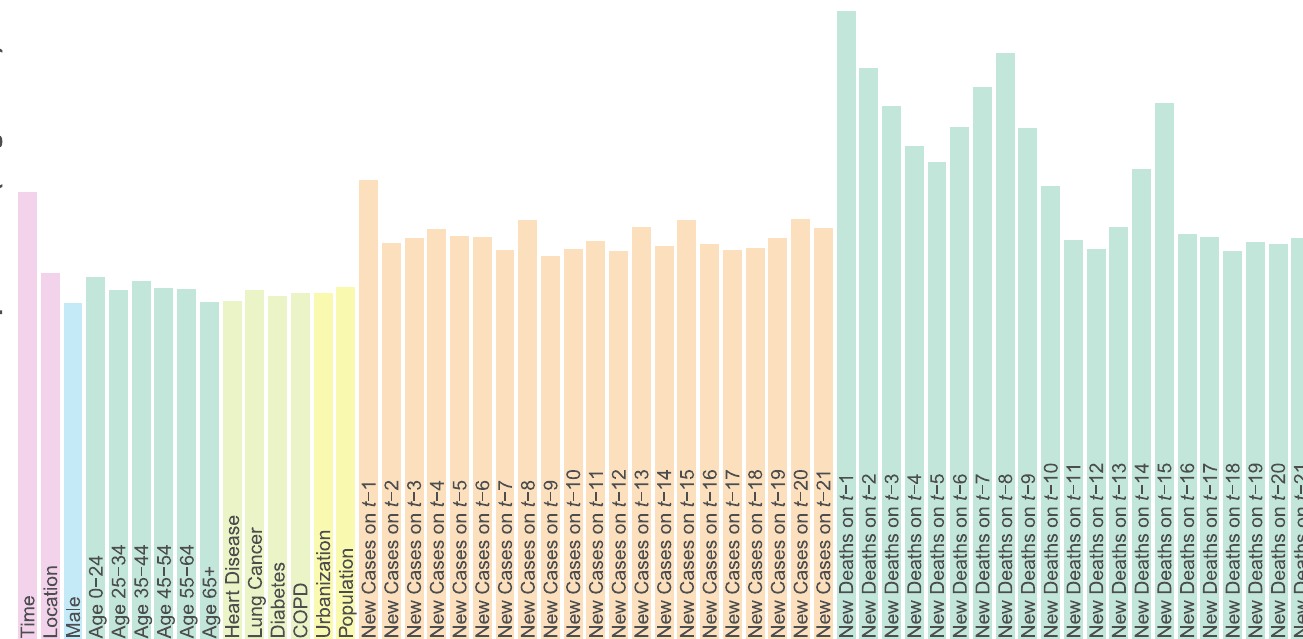
Fig 2. Death model covariate importance. Covariate importance scores on the log scale for the random forest death model as the mean decrease in MSE associated with permutation of the variable’s values.